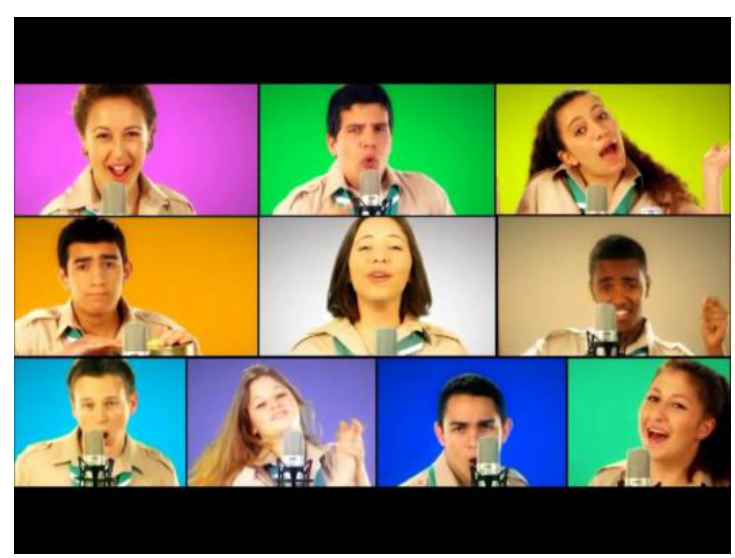
Figure 1. Sample image 1 and related API output.